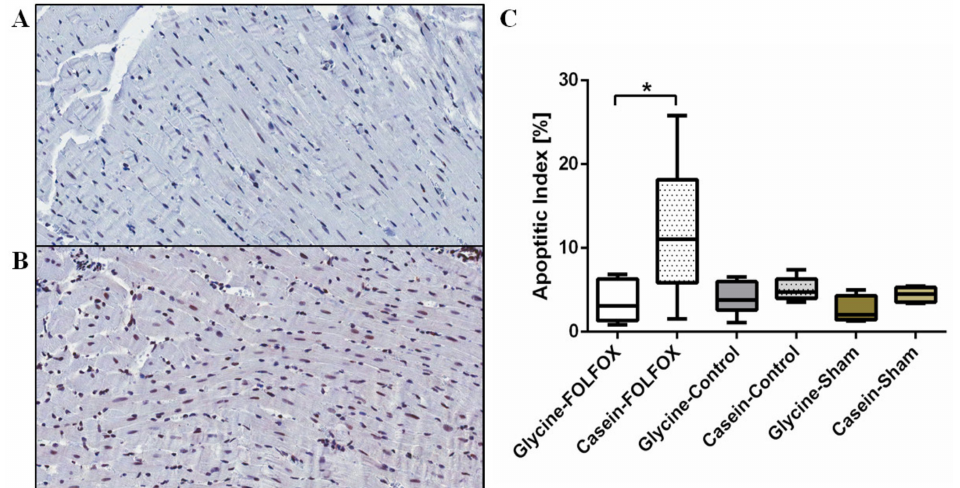
Figure 6. The apoptotic index measured by immunohistochemistry with anti-Caspase 3 antibody. Representative pictures at 100 × magnification of anti-Caspase 3 staining for fibrous tissue in the myocardium of animals treated with FOLFOX and glycine ( A ) and FOLFOX alone ( B ). The apoptotic cell rate was significantly higher in the FOLFOX-alone group compared to that in the group treated with FOLFOX with glycine, * p < 0.05 ( C